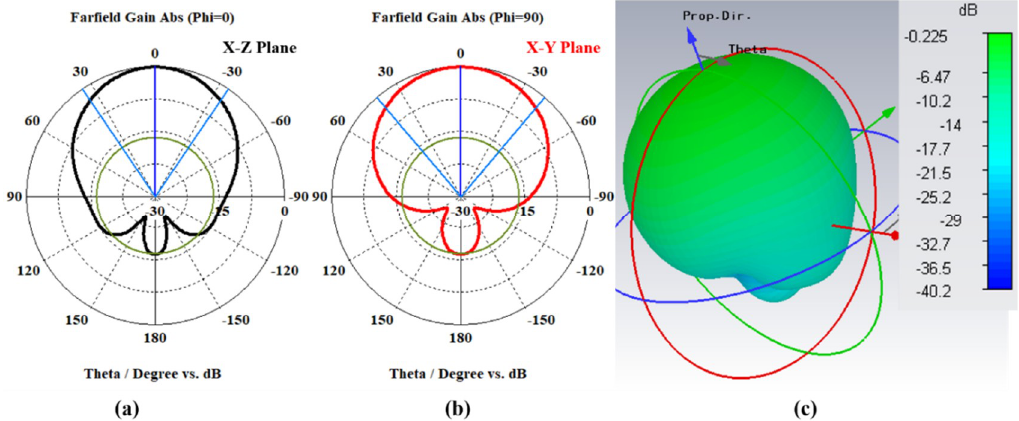
Figure 5. ( a ) differential probe method; ( b ) simulated and measured tag antenna’s impedance.